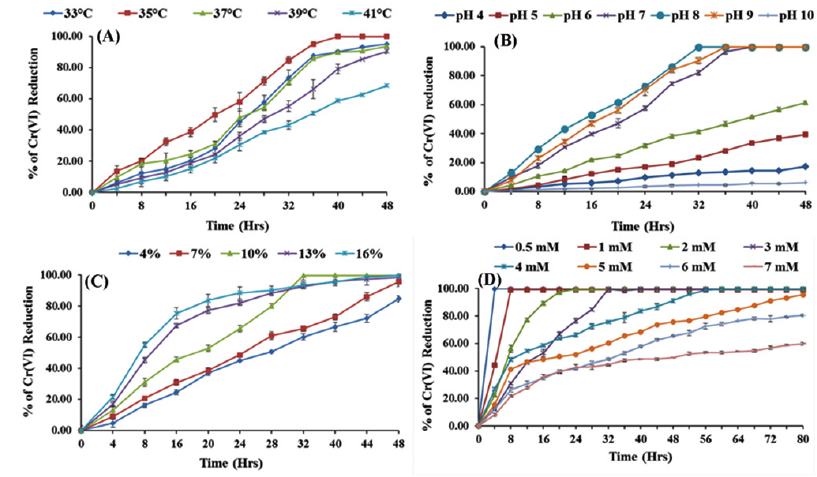
Fig. 3. Effect of experimental conditions on Cr(VI) reduction by SN6 (A) Temperature, (B) pH, (C) Inoculum